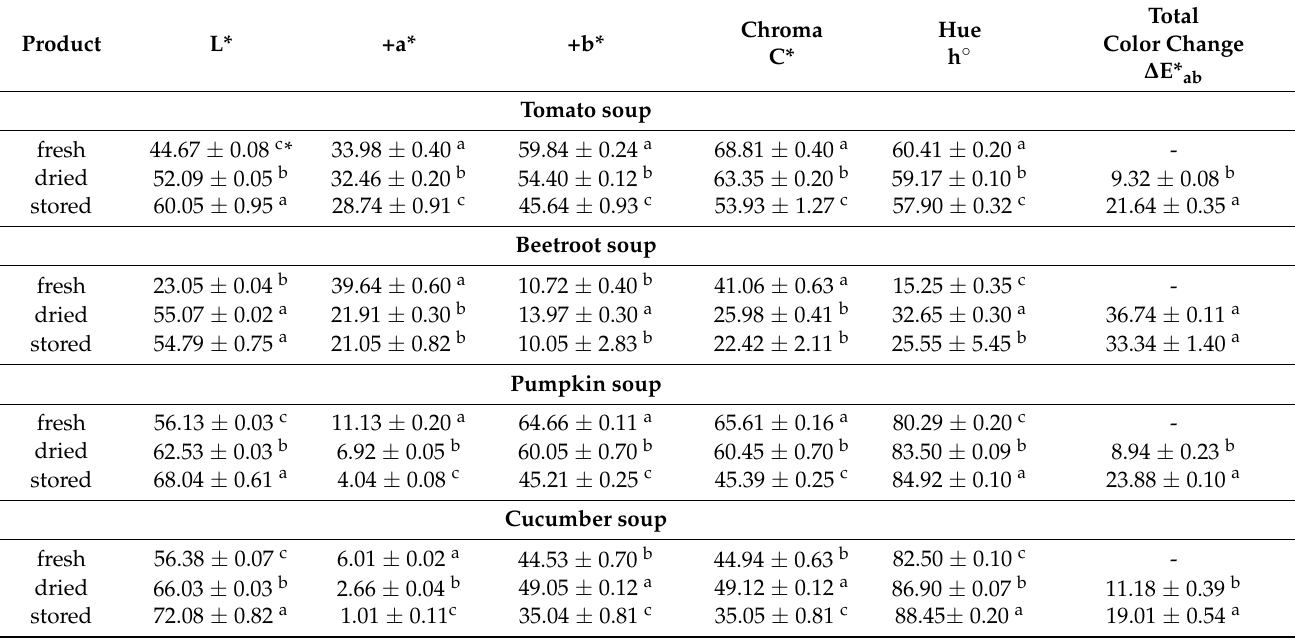
Table 5. Color of different fresh, freeze-dried, and stored